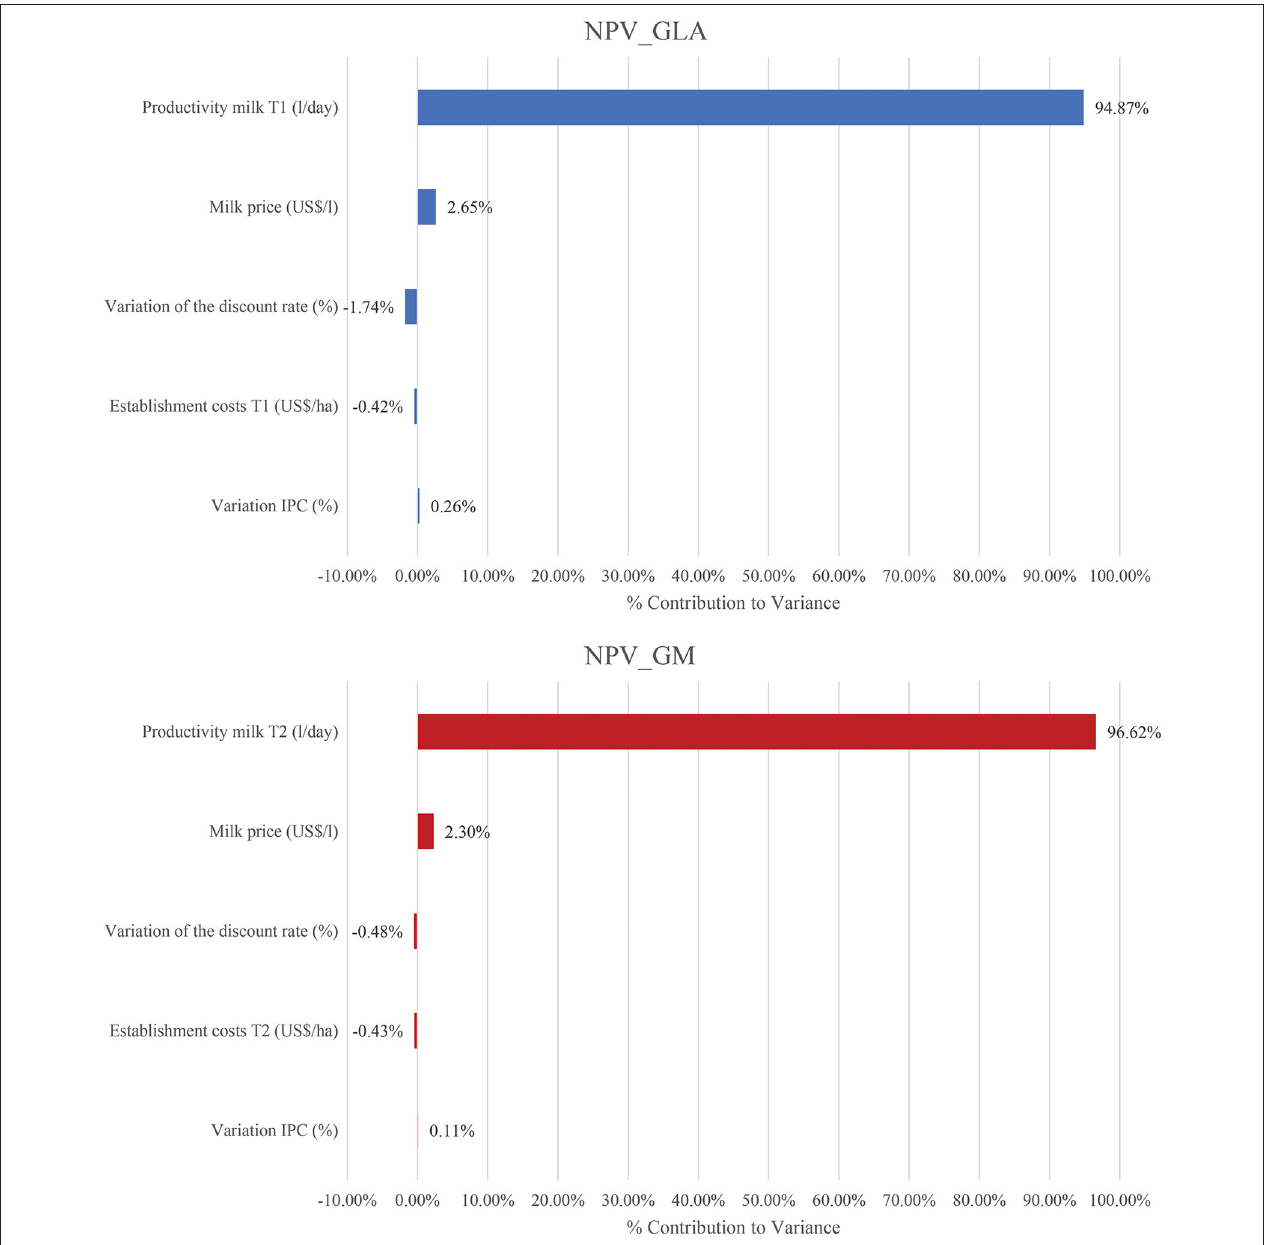
FIGURE 4 | Contribution to the NPV variance for the grass-legume association and the grass monoculture. GLA, Grass-legume association; GM, Grass